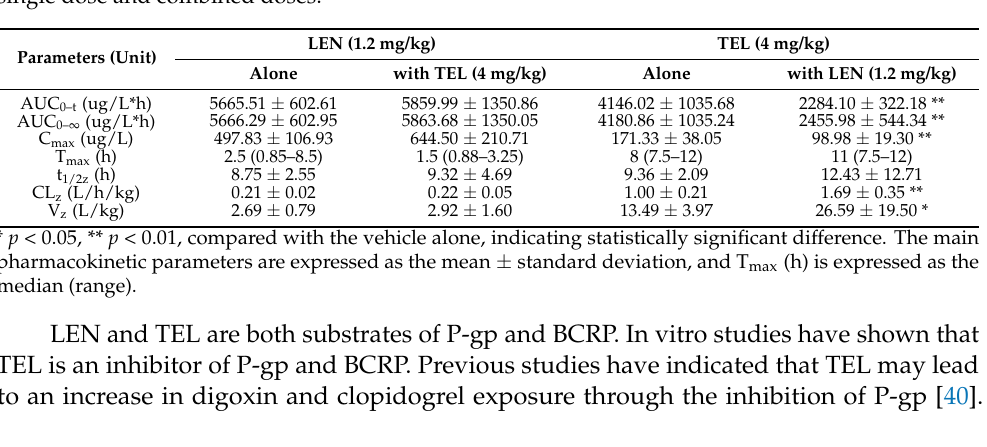
Figure 4. ( A ) The mean plasma concentration–time curves of LEN after oral administration, I LEN : 1.2 mg/kg LEN, II LEN+T : 1.2 mg/kg LEN combined with 4 mg/kg TEL; ( B ) the mean plasma concentration-time curves of TEL, III TEL : 4 mg/kg TEL, IV TEL+L : 4 mg/kg TEL combined with 1.2 mg/kg LEN after oral administration. Table 4. Pharmacokinetic parameters of LEN and TEL in rat plasma after the oral administration of single dose and combined